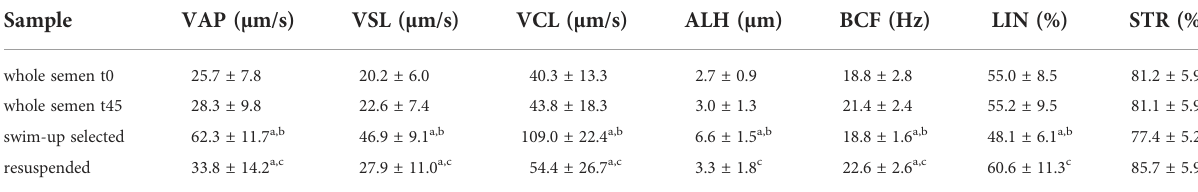
TABLE 2 Mean ± sd of kinematic sperm parameters, evaluated by CASA system, are reported in whole semen t0, whole semen t45, swim-up selected and resuspended samples (n=11).